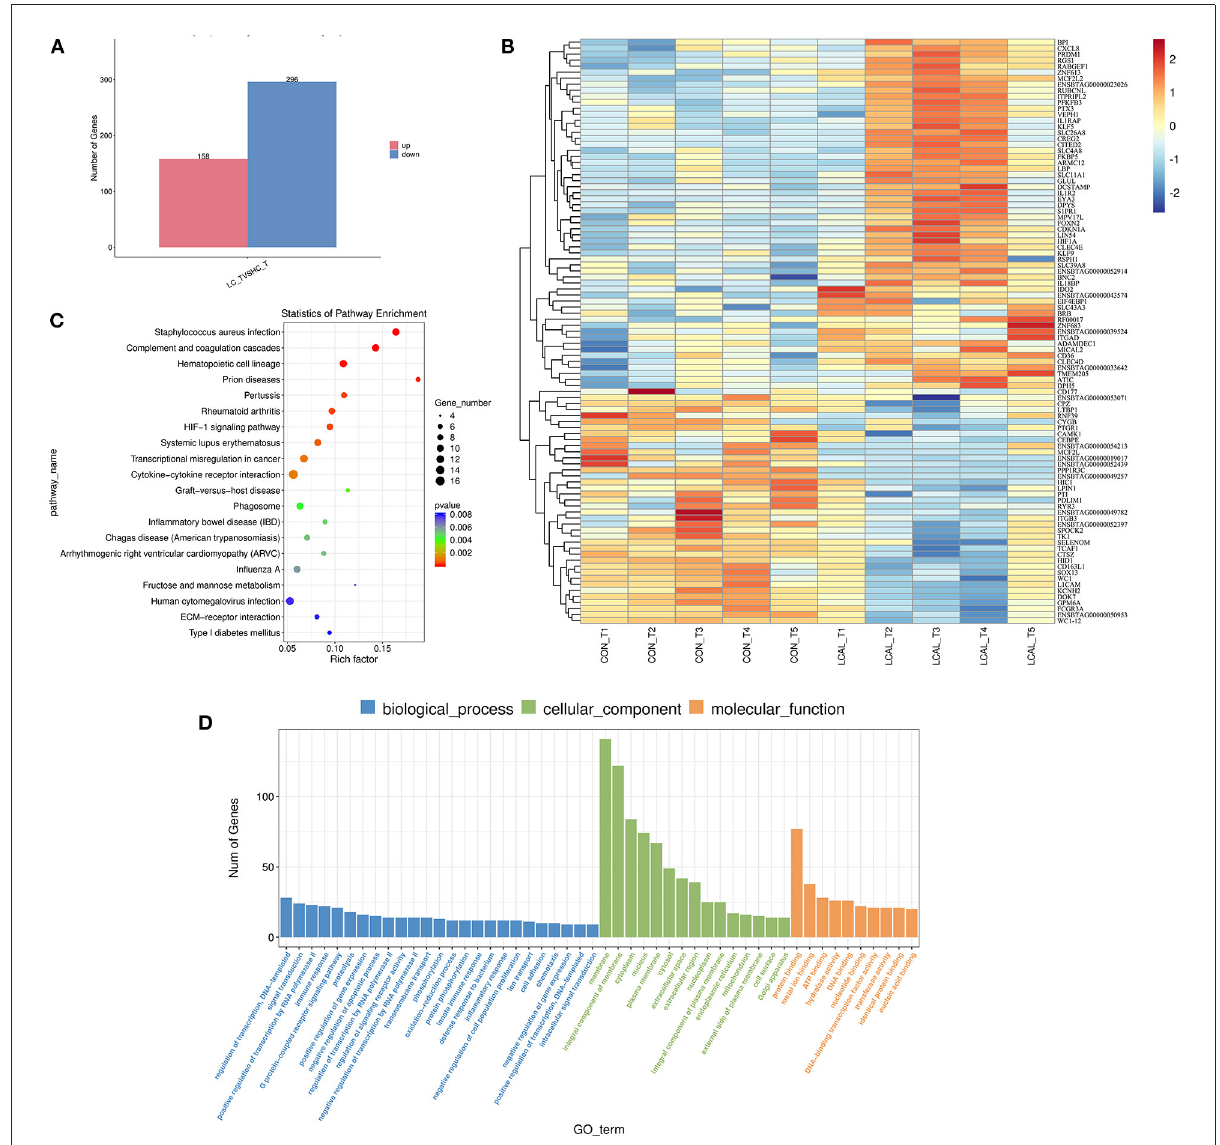
FIGURE1 (A) Number of differentially expressed genes in PMNL from dairy cows with low plasma calcium [means ± SEM ( n = 5)]. (B) Hierarchical clustering of differentially expressed genes in dairy cows with low plasma calcium. Red represents the up-regulated genes, and blue represents down-regulated genes [means ± SEM ( n = 5)]. This pathway was generated through the use of omicstudio (https://www.omicstudio.cn/login). (C) Ggplot2 was used to display the GO enrichment analysis results in the form of a scatter diagram (bubble diagram). In the horizontal coordinate, Rich factor represents the number of differentially expressed genes located in the GO/the total number of genes located in the GO (Rich factor = S gene number/B gene number) [means ± SEM ( n = 5)]. This pathway was generated through the use of omicstudio (https://www. omicstudio.cn/login). (D) Histogram of GO enrichment analysis of differentially expressed genes in PMNL from dairy cows with low plasma calcium. Data are the analysis of GO Terms enriched in biological processes, cell components and molecular functions. The number of different genes (S gene number) was annotated by GO_Term from largest to smallest, and select GO_Terms include the Top25, Top15, and Top10 differentially expressed [means ± SEM ( n =